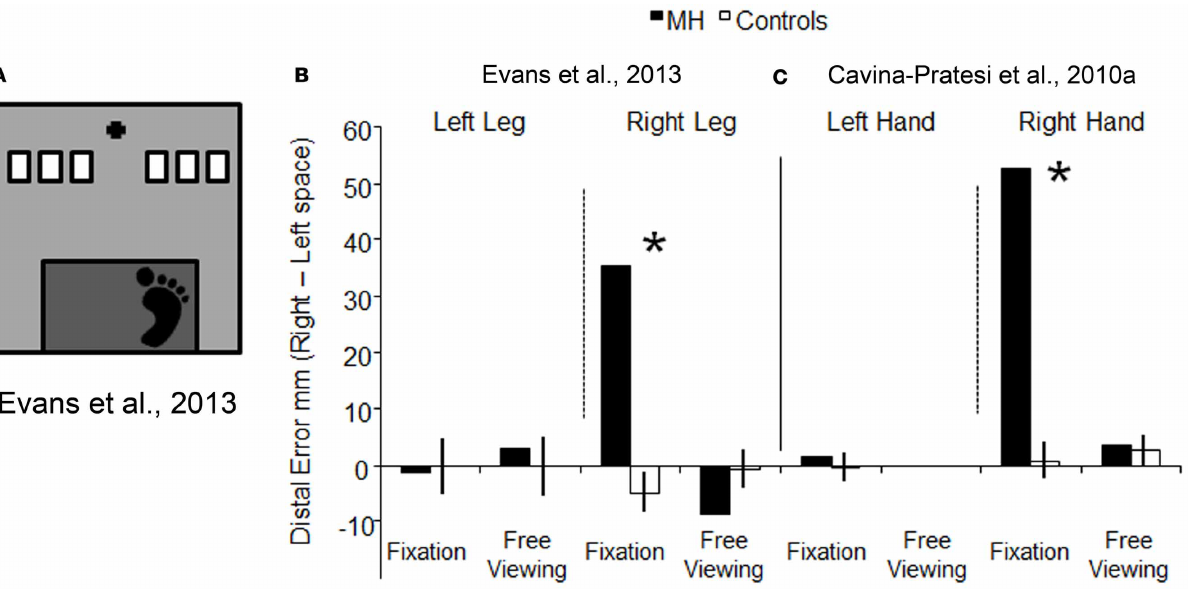
bothM.H.(inwhite)andage-matched controls(inblack).Datahavebeenplotted by subtracting the error in left space from the error in right space. (C) depicts the error for the upper limbs (arm) showed in graph 3b, by subtracting reaching errors made in the left visual field from errors made in the right visual field [this allows adirect comparison between the errors made with the leg in (B) and the arm in (C) ]. Reaching errors executed in free viewing using the left hand are not depicted as data were not collected for that condition. For both graphs, the higherthevalueontheyaxis,thegreaterthereaching errorintherighthalf-field. Asterisks highlight significance differences between M.H. and